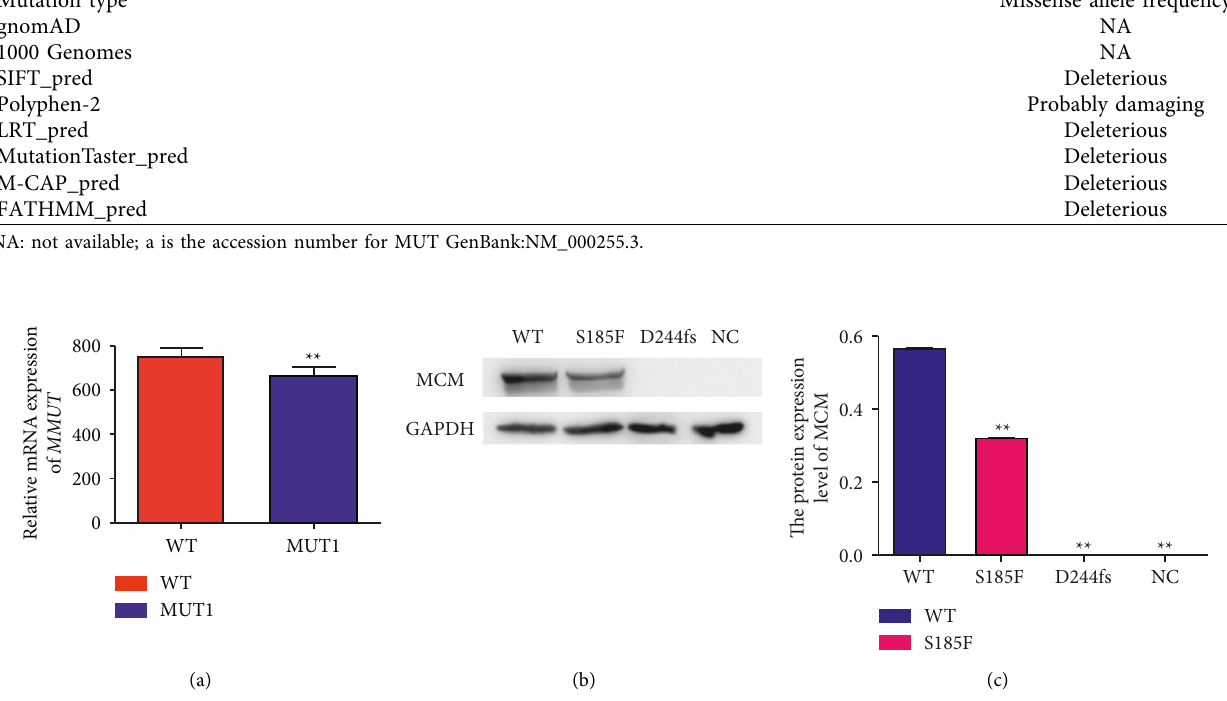
Figure 3: Effect of MMUT mutations on MMUT protein and mRNA levels in HEK293T cells. (a) The relative mRNA expression of MMUT was normalized to HEK293T cells transfected with the wild-type plasmid. The data collected from three independent ex- periments were subjected to statistical analysis ( ∗ P < 0 . 05; ∗∗ P < 0 . 01 vs. WT). (b-c) The relative protein expression was normalized to HEK293 T cells transfected with the wild-type plasmid. The data collected from three independent experiments were subjected to statistical analysis ( ∗ P < 0 . 05; ∗∗ P < 0 . 01 vs. WT). WT: wild type; MUT1: c.554C > T (p. S185F); MUT2: c.729–730insTT (p.D244Lfs ∗